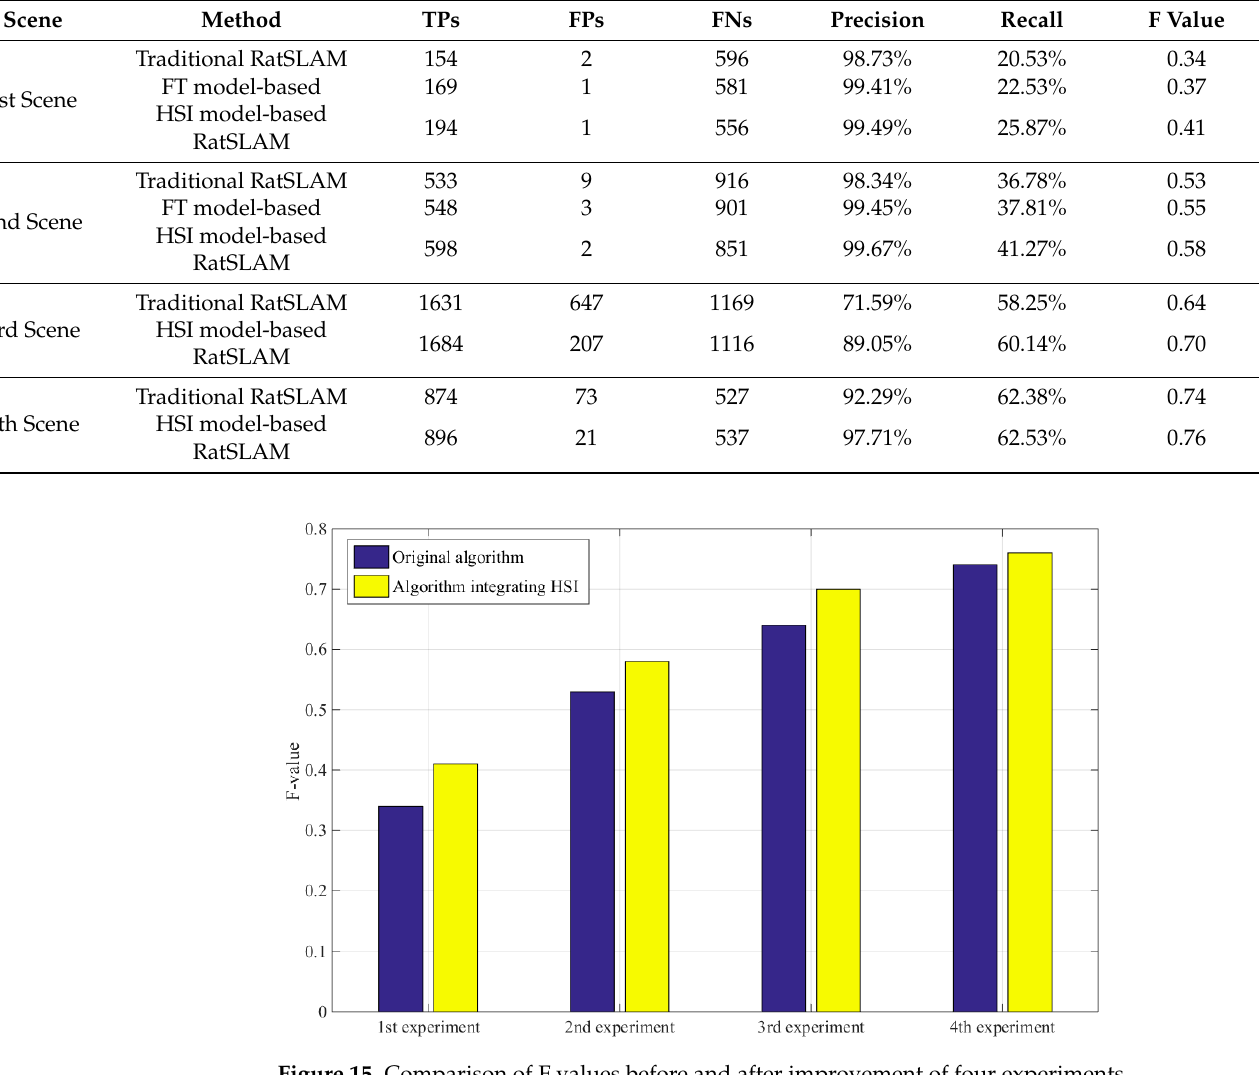
Figure 15. Comparison of F values before and after improvement of four experiments.